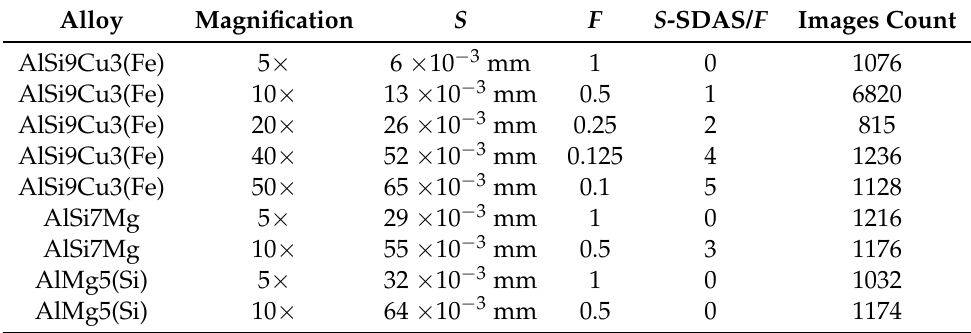
Figure 4. Images of different types of defects used for the training: ( a , b )—air and shrinkage porosity defects; ( c , d )—scratches; ( e )—blurred image; ( c , f , g , i )—different brightness and contrast of the image; ( g , h )—ECS (some images are purportedly of lower quality). Table 2. Images count per different material and different